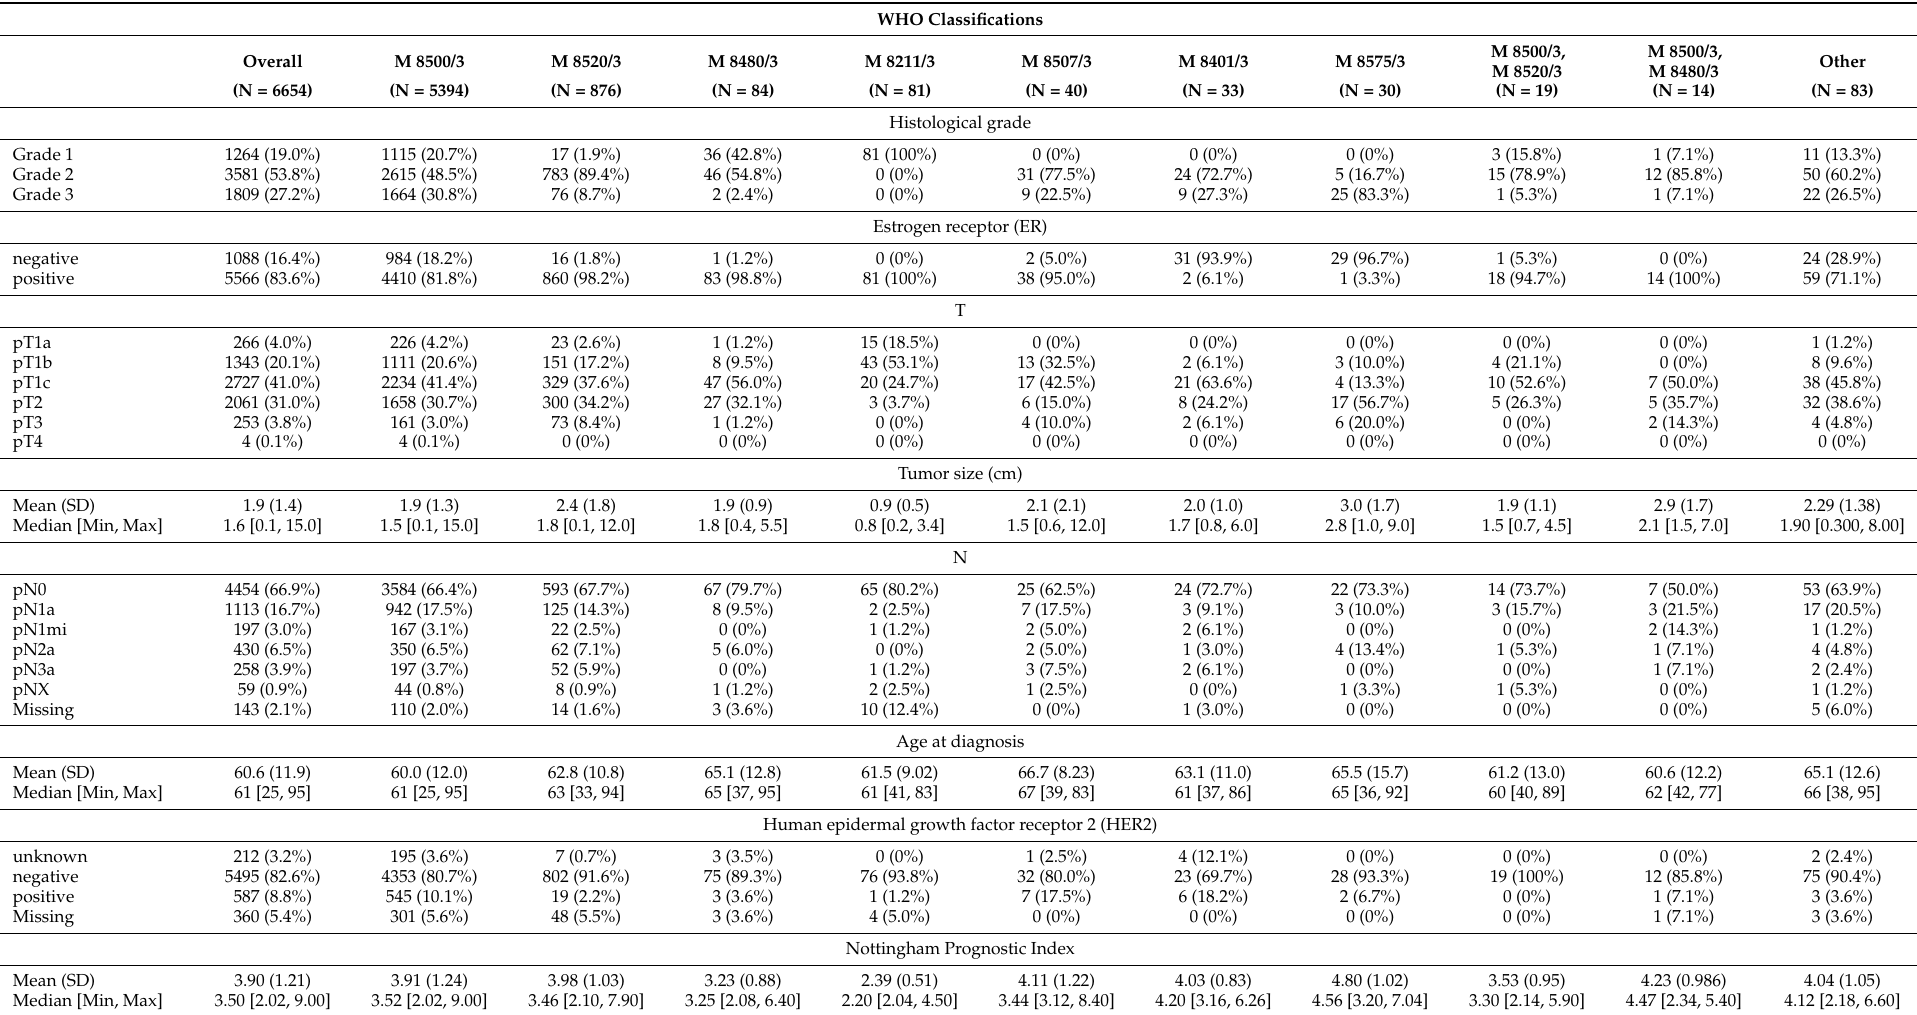
Table 1. Distribution of patients and tumor characteristics among different WHO tumor classifications. Classifications with 10 or less expressions were combined into one